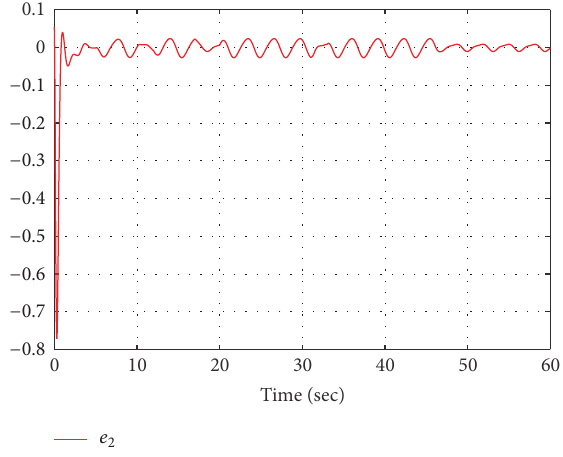
Figure 4: The trajectory of tracking error 𝑒 2 .